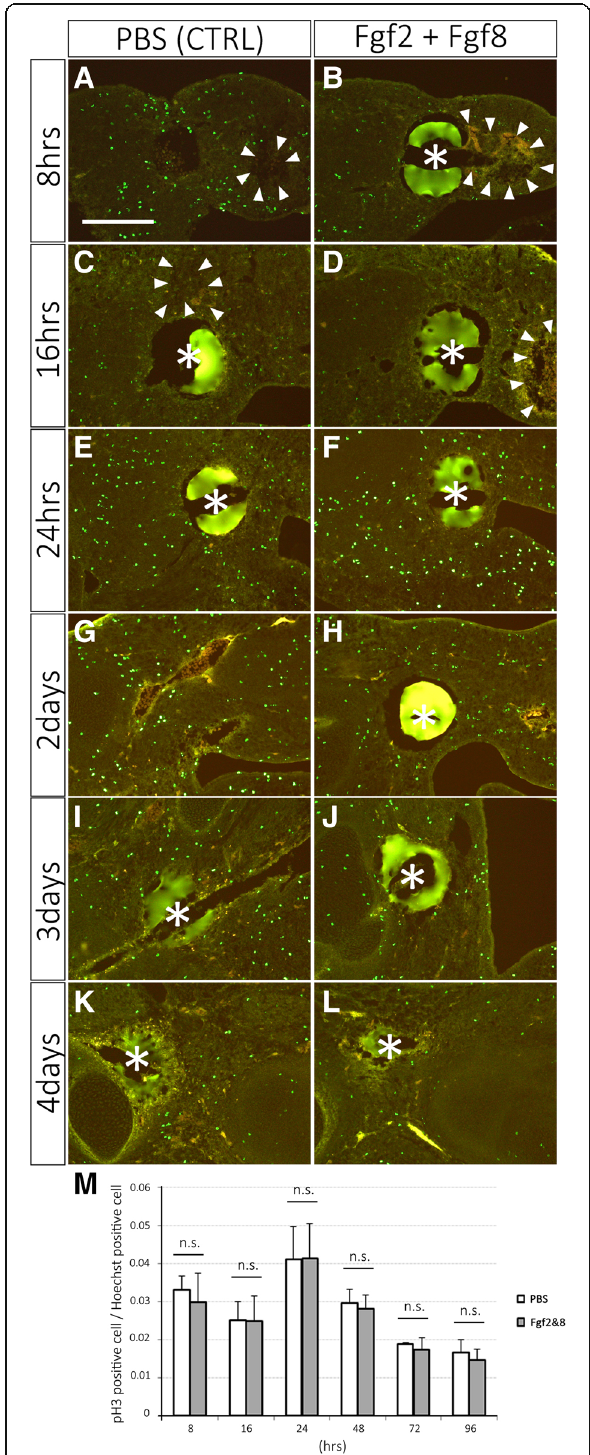
Fig. 4 Mitogenic activity was measured by pH 3 immunofluorescence. The left column shows the control samples with the PBS-soaked bead. The right column shows the limb buds with the Fgf2 + Fgf8-soaked bead. Asterisks and arrowheads indicate the beads and the ischemic region, respectively. The scale bar in A is 250 μ m. (M) The summary of the result of A – L and the statistical analysis. n.s. = no significant